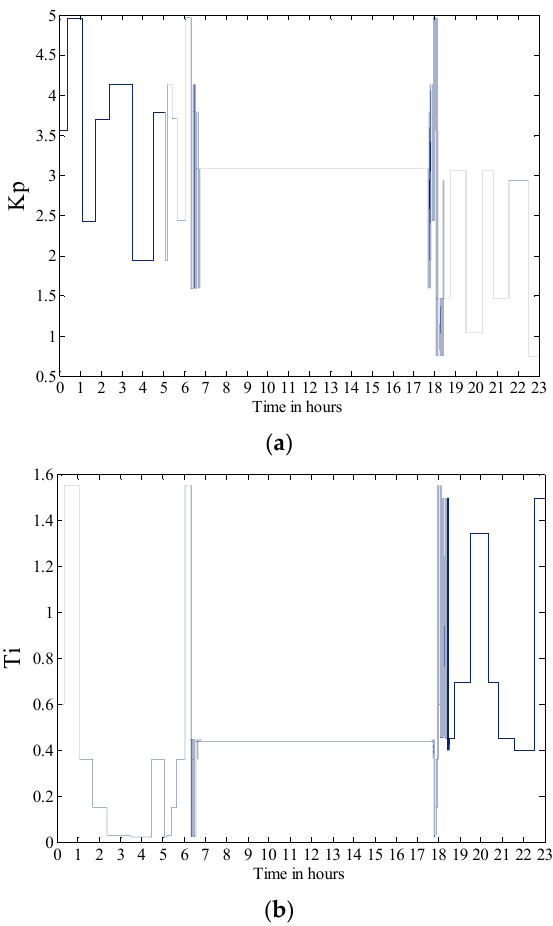
Figure 10. ( a , b ) show the variation of K p and T i respectively for different fuel cell controller set points using genetic algorithm (GA). The K p and T i generated by the FIS system is shown in Figure 11 for different values of input ( P FCref ).